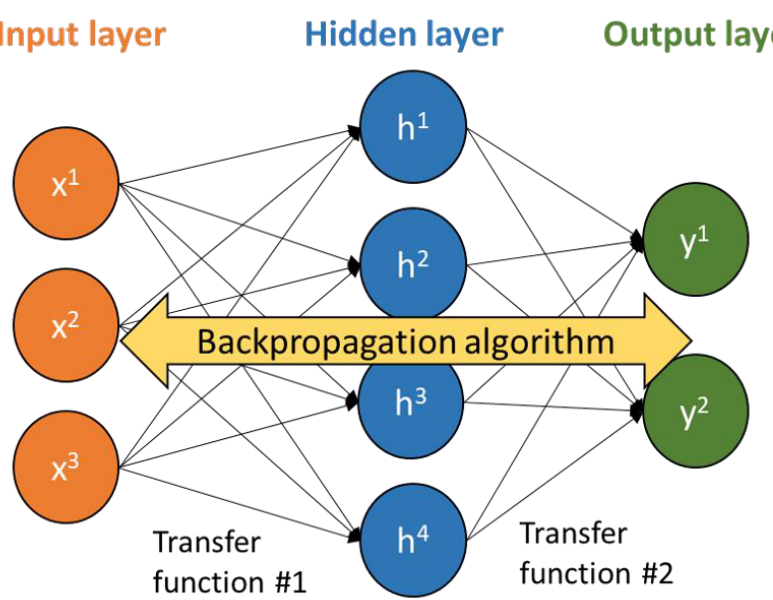
Figure 4. Schematic representation of a three-layer back-propagated ANN with 3 inputs, 4 hidden neurons, and 2